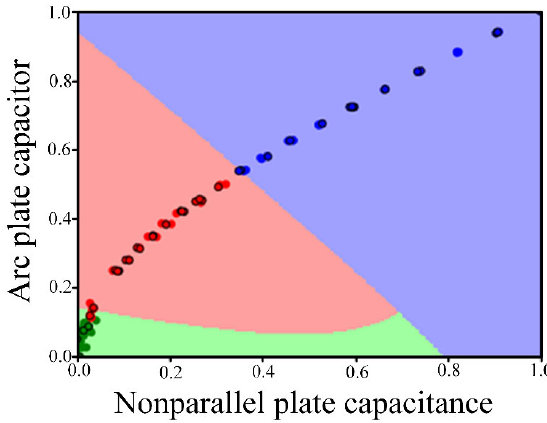
Figure 16. Qualitative classification results of wear particles used in the experiment.